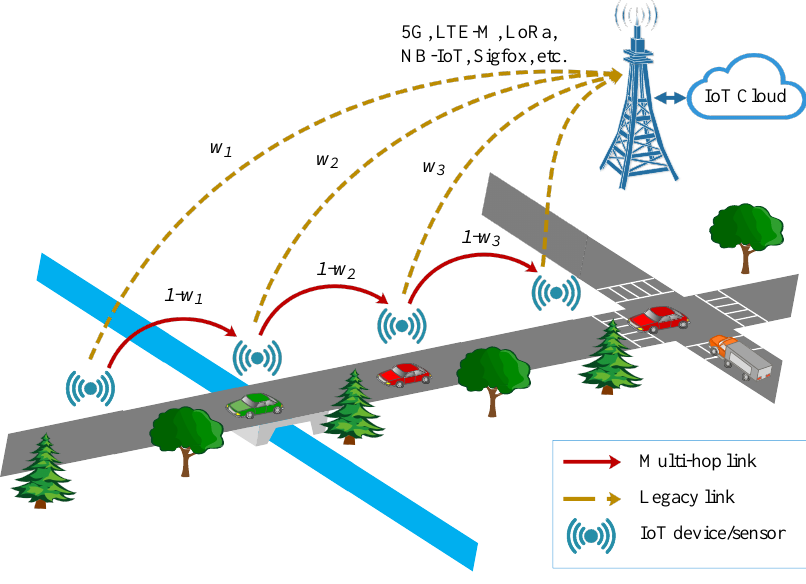
Figure 2. A two-tier IoT